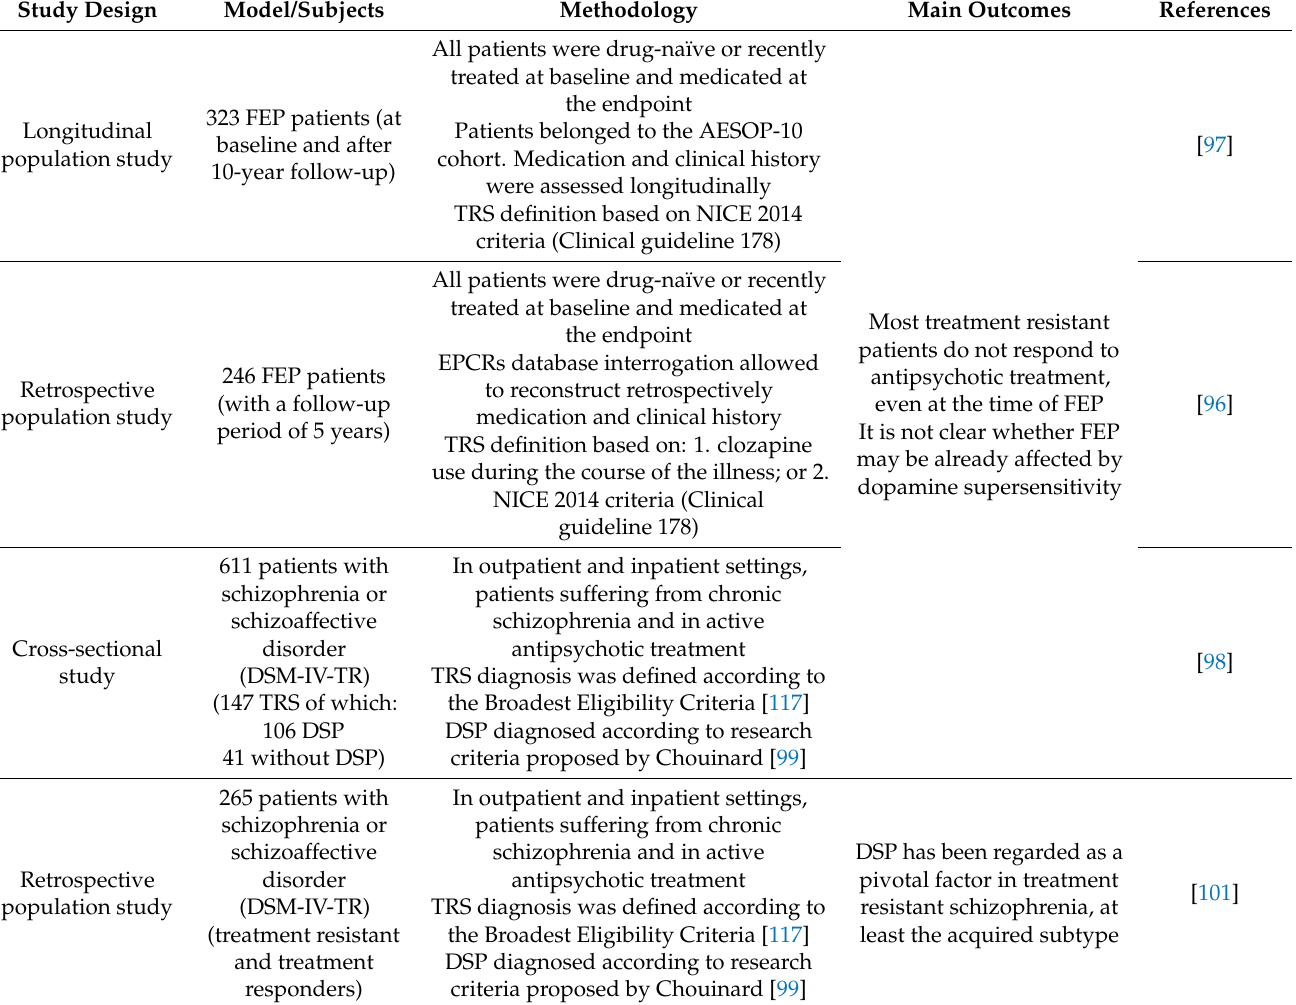
Table 4. Comparison of treatment resistant and treatment responder patients/preclinical paradigms evaluating D2R-related biological mechanisms of non-response to antipsychotics. AESOP-10: Aetiol- ogy and Ethnicity in Schizophrenia and Other